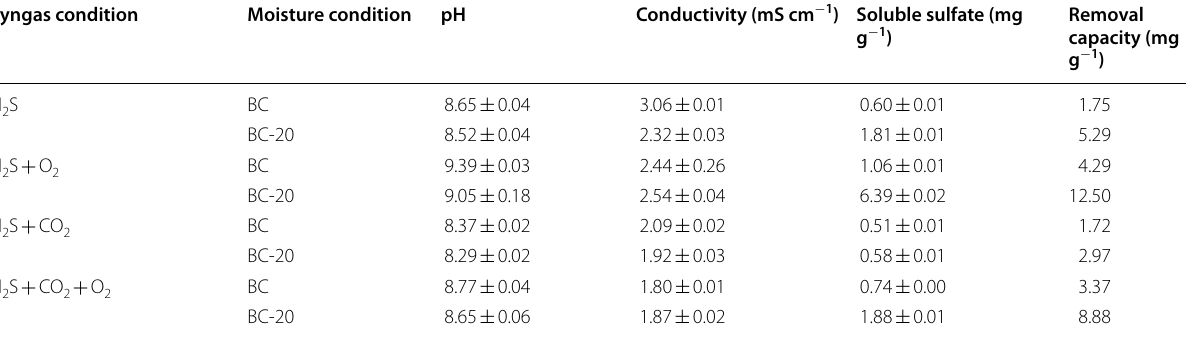
Table 2 H S removal capacities and changes in pH and soluble sulfate content for the DFW-BC 2 Syngas